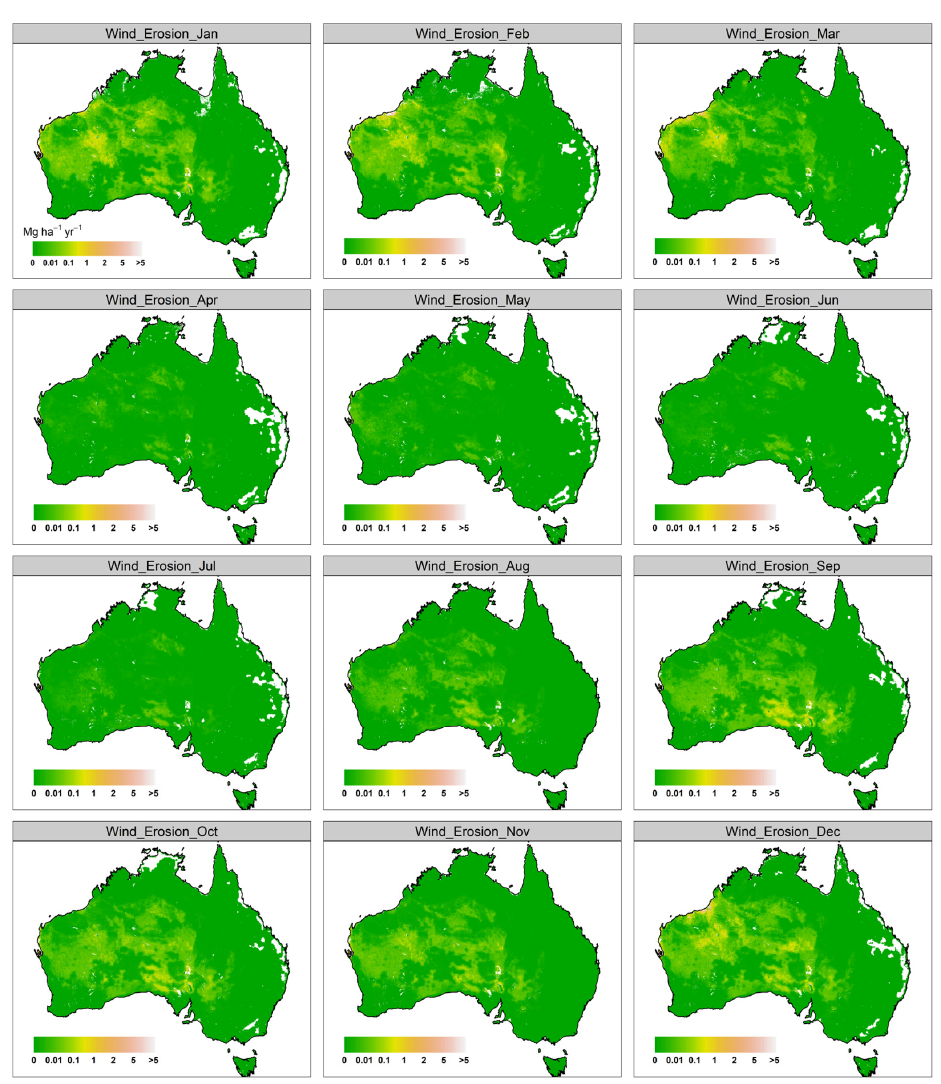
Figure 5. Bar chart of monthly water erosion by state in 2001–2020.